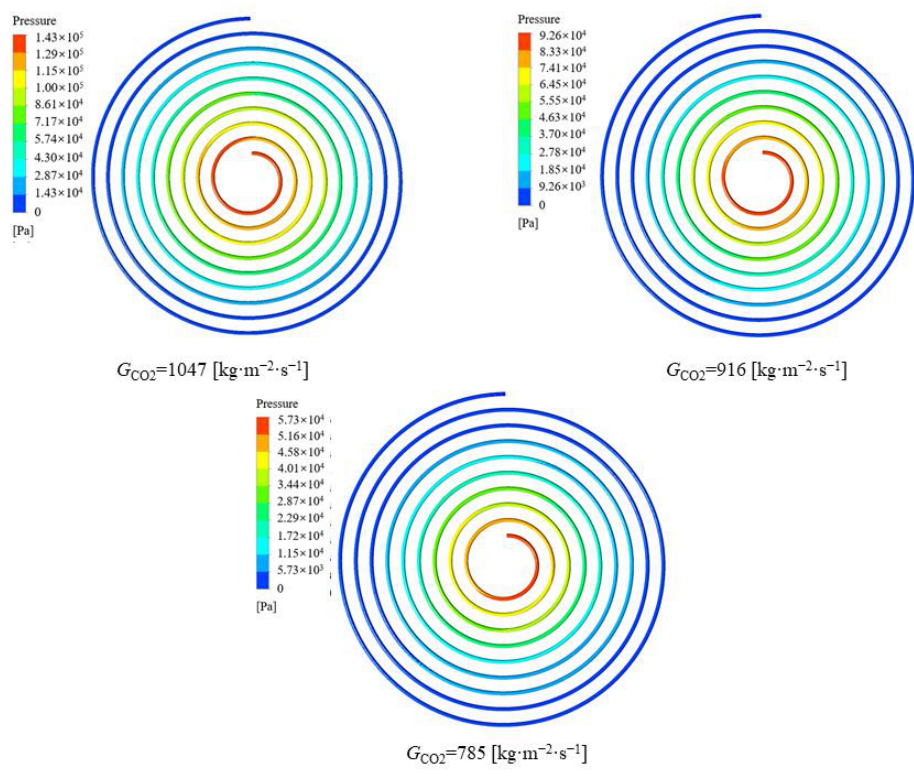
Figure 17. Variation in the pressure contour of CO 2 at different mass fluxes.